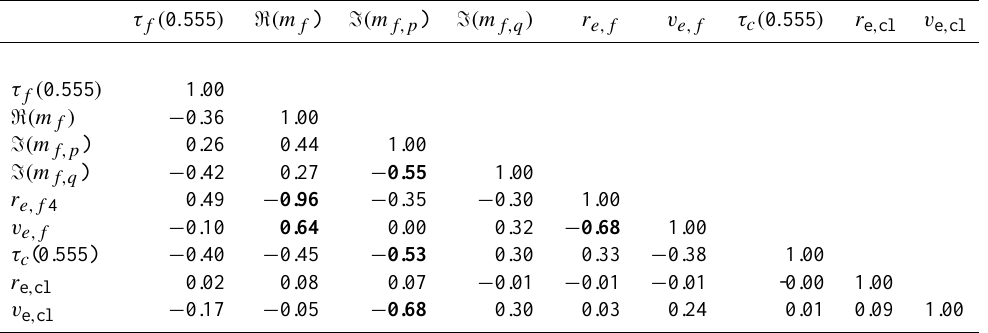
Table 5. Correlation matrix for a simulated AAC scene with ( τ f (0.555)=0.1) and an optimization utilizing angles within (60 ◦ ) of nadir. Elements with absolute values greater than 0.5, indicating strong correlation, are in bold.